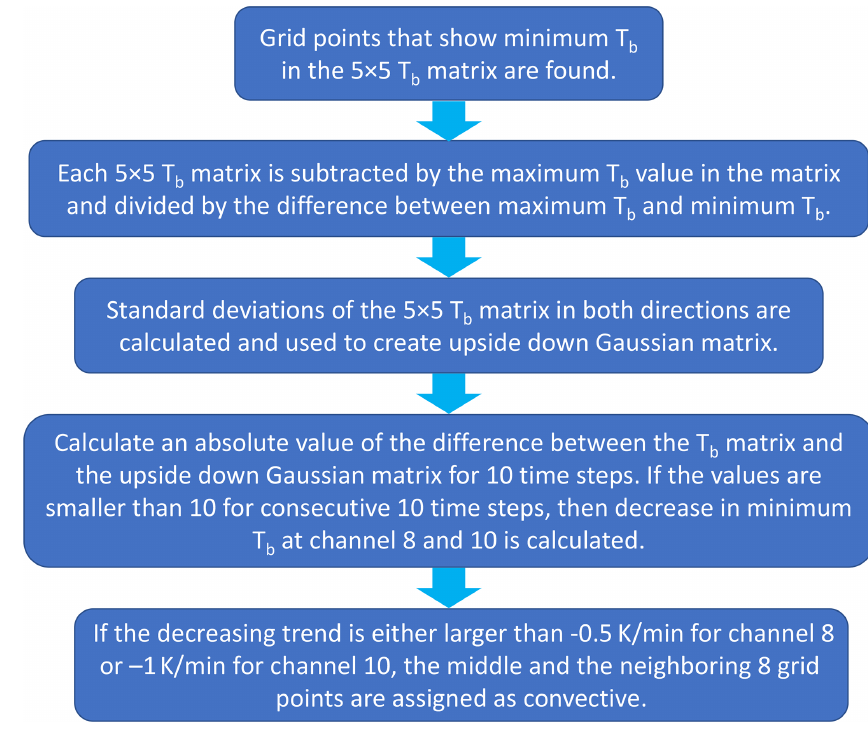
Figure 2. A flow chart to summarize the growing cloud detection